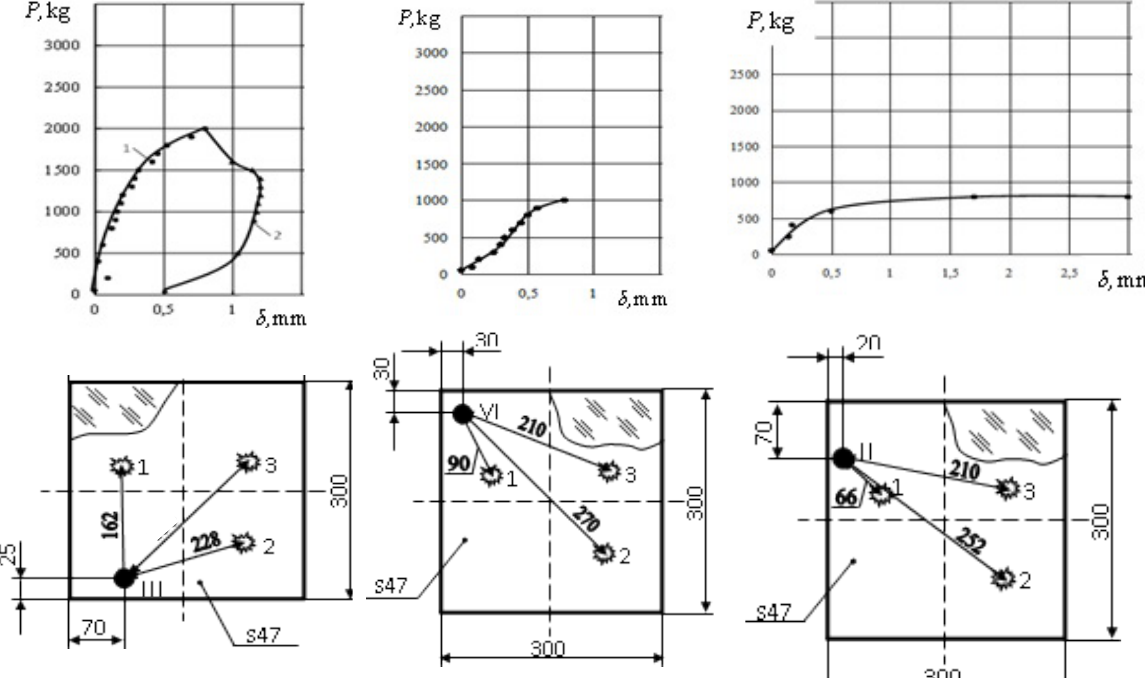
Fig.10 the deformation curves of the single areas of the bulletproof glass at a distance of 162 mm, 90 mm and 66 mm from the first impact region. The minimum values of the secant elastic modulus are 307 MPa and 353 MPa for areas that are close to the second and third impact region. Ultimate compressive stress for these areas does not exceed 10 ... 13 MPa. This indicates an extremely large failure of bulletproof glass due to multiple ballistic loading at a limited distance between impacts. The large influence of the corner edge along with a small distance from the center of the second impact is indicated by the low values of the Е 0,02 , which is 367 MPa and ultimate compressive stress σ c = 10 MPa for the area XIV. The areas I and III kept the rigidity ( Е 0,02 = 2666 MPa and 1905 MPa) and the maximum ultimate compressive strength σ = 28 MPa. This is due to the farthest distance from the impact region - 125mm and 150mm. It is found that all values that characterize the post-failure rigidity and the post-failure structural glass strength after multiple impact loading are in some region, limited by the curves “Secant effective modulus of elasticity Е 0,02 – distance to the nearest impact region r ” “ ultimate compressive stress σ c – distance to the nearest impact region r ”, shown in Fig.